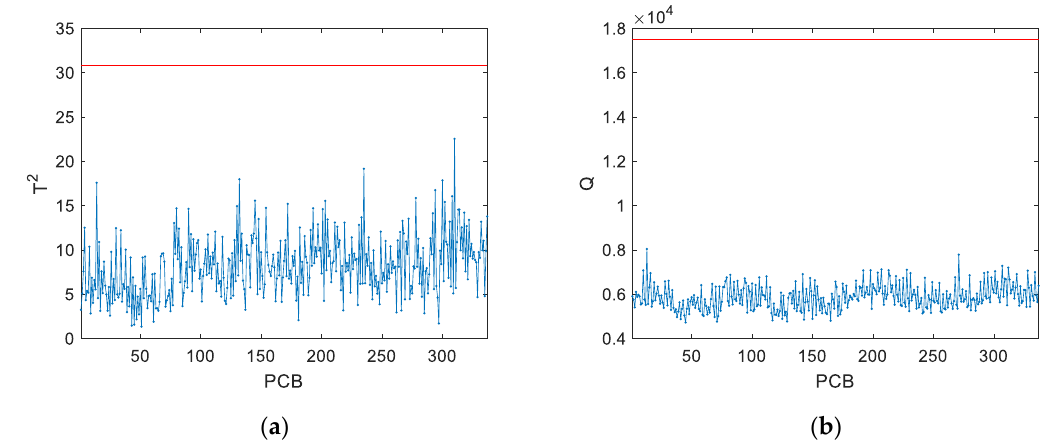
Figure 10. Control charts for the PCBs in CS1: ( a ) T 2 -statisctic; ( b ) Q -statistic.